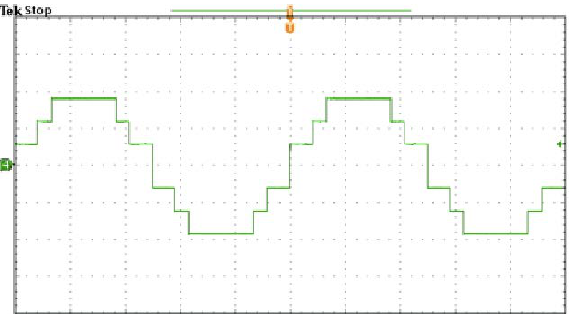
Figure 13. The experimental output voltage (top trace) in Mode I: no load condition. (Scale: vertical: 50 V/div, horizontal: 4.0 ms/div).